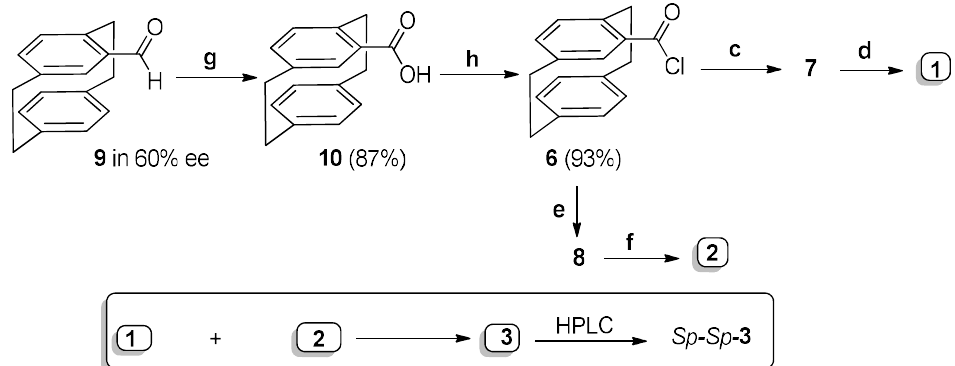
Figure 4. Analytical HPLC of 60% ee- 8.